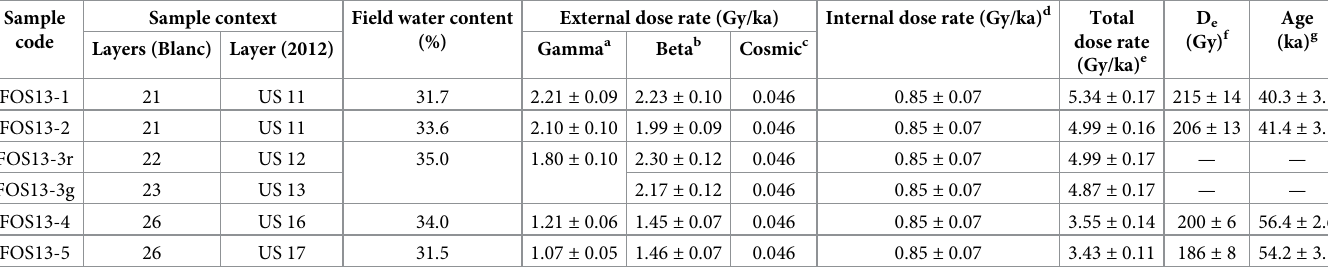
Table 2. Dose rate data, D e values and luminescence ages for all samples in this study.